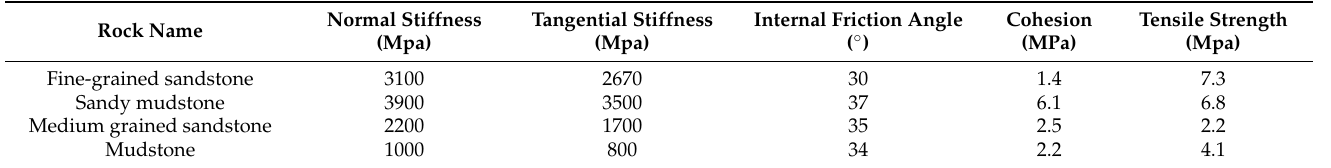
Table 2. Joint’s mechanical parameters.